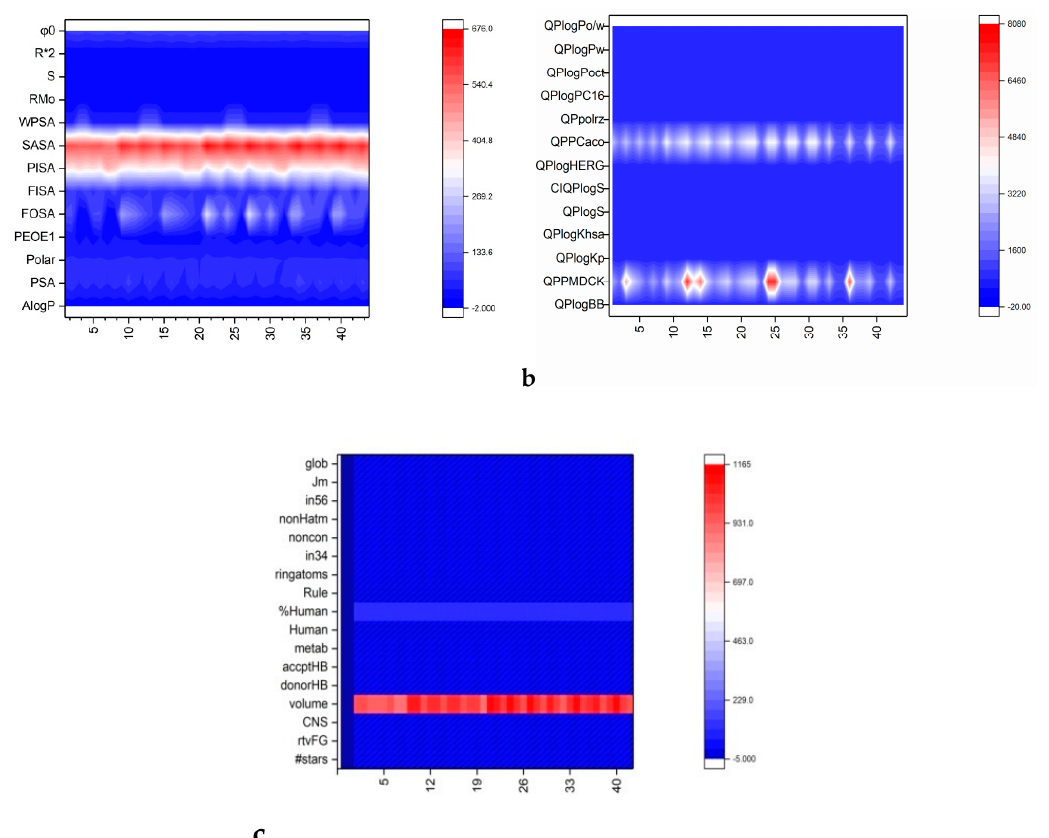
Figure 2. Compounds’ (#44) lipophilicity and drug-like properties represented as heatmaps; ( a ) RMo values for each compound represented together with some computed lipophilicity-related descriptors. ( b ) QPlog-related properties for each compound. ( c ) Drug-like properties for each compound. Lipophilicity related parameters—isocratic retention factor (R M ), relative lipophily (R M0 ), slope ( b ), chromatographic hydrophobic index ( ϕ 0 ), together with some computed descriptors—are represented in Figure